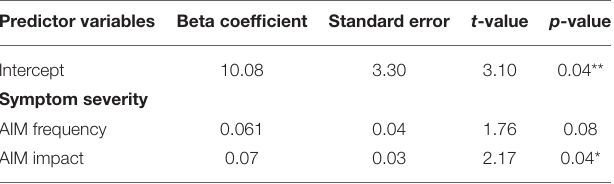
TABLE 3 | Model 2: multiple linear regression of family life, AIM frequency, and AIM impact.